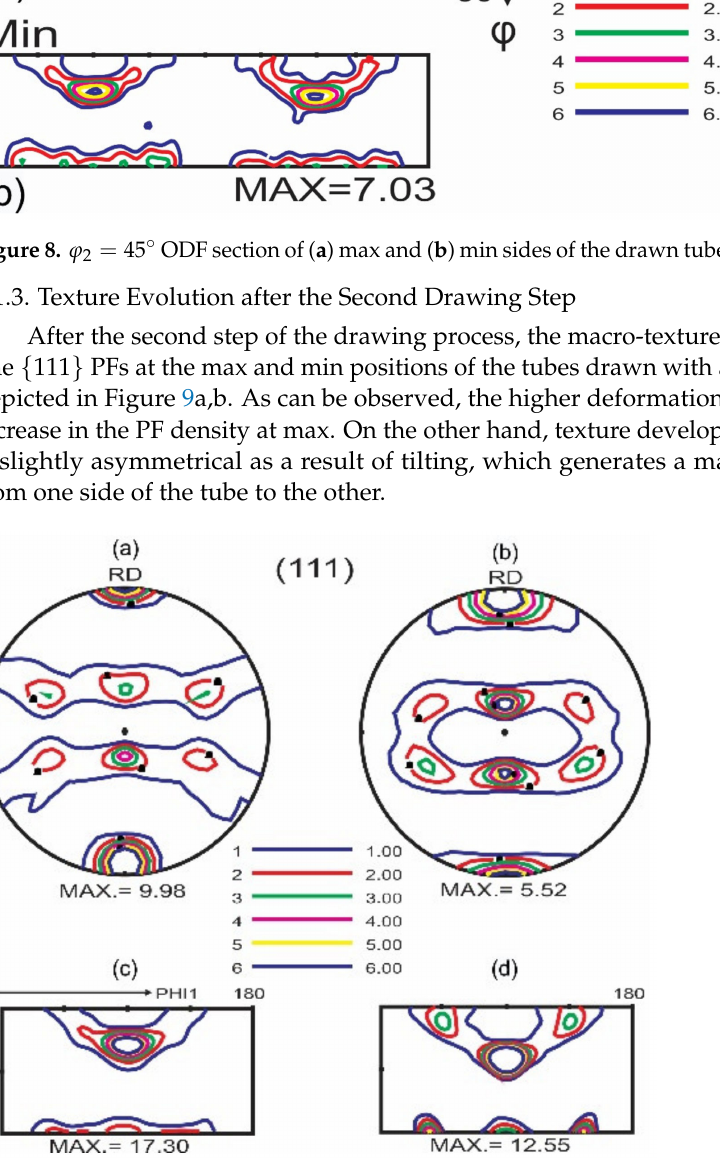
Figure 9. { 111 } PFs after the 2nd drawing step at ( a ) max, ( b ) min. 45 ◦ ODF section at ( c ) max and ( d )